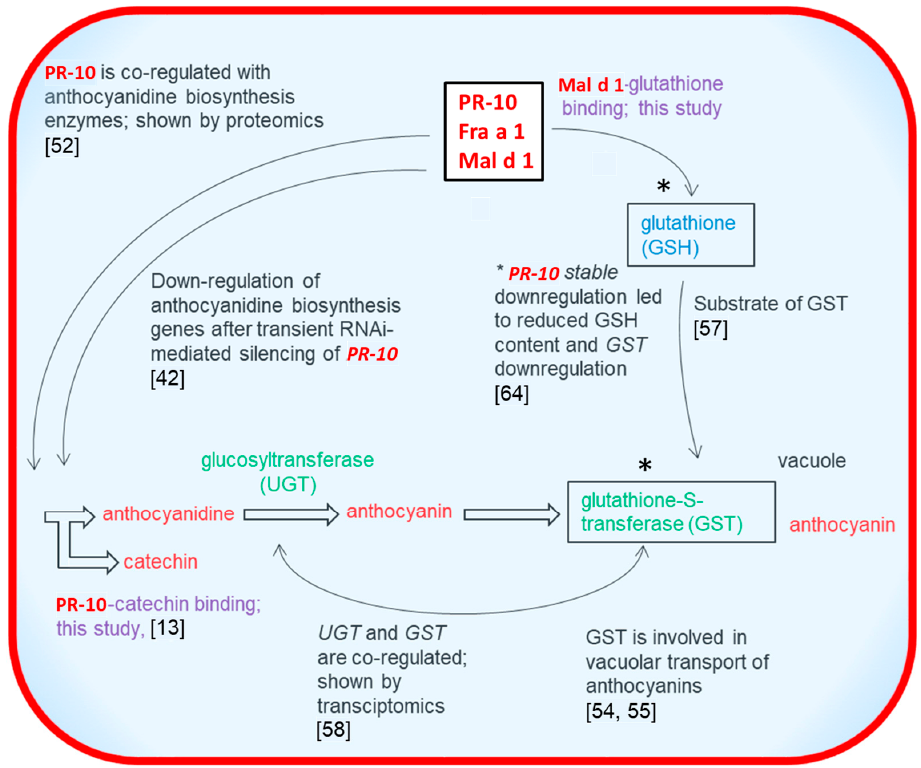
Figure 4. Relationships of PR-10 proteins, flavonoid/anthocyanin biosynthesis genes/enzymes, glutathione content, and glutathione S-transferase expression as reported and shown in this study. * PR - 10 stable downregulation led to reduced GSH content and GST downregulation [64].